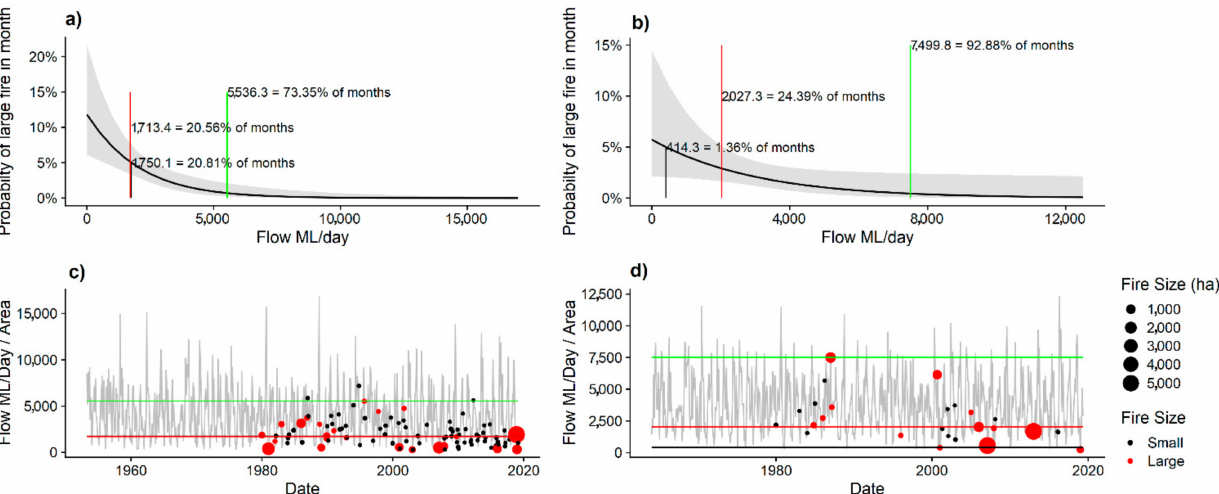
Figure 4. Logistic regression model of large fire occurrence against river flow for ( a ) Franklin River and ( b ) Davey River, showing the 5% probability low flow threshold in black, the median large fire occurrence in red, and the high flow threshold in green. Time series plots of monthly river flow for the ( c ) Franklin River and ( d ) Davey River are shown below, with the three threshold flows indicated, and large (red) and small (black) fire occurrences and size indicated by circles. Note the red and black lines overlap in panels ( a , c ). Fires only occur at river levels where there is a close relationship between river flow levels and soil moisture (Figure